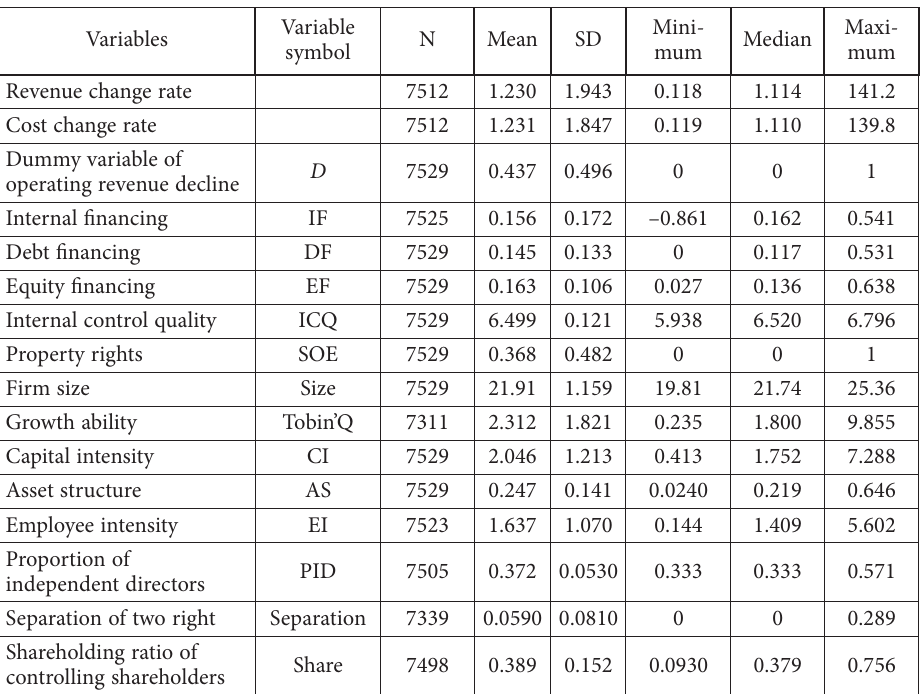
Table 1. Descriptive statistics of main